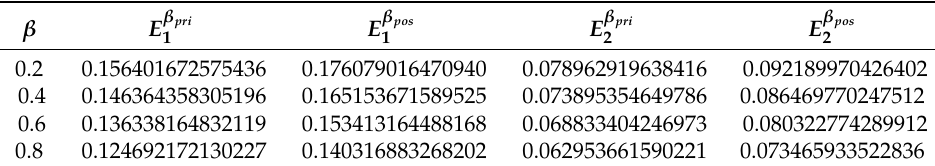
Table 2. The error estimation between the exact and regularized solutions with the different values of β , ε = 0.01 and N =